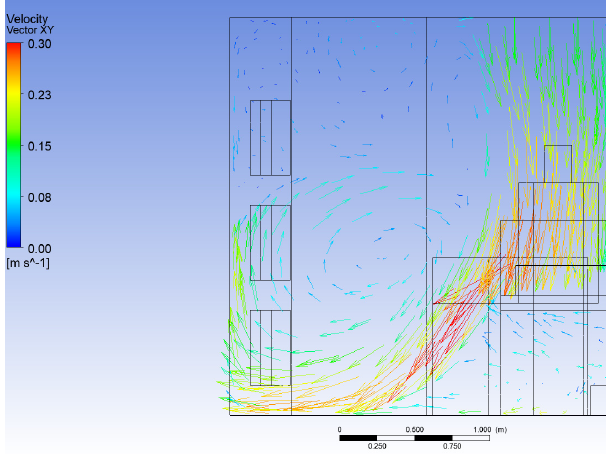
Figure 12. Air velocity vectors at V IT 2 reference volume.